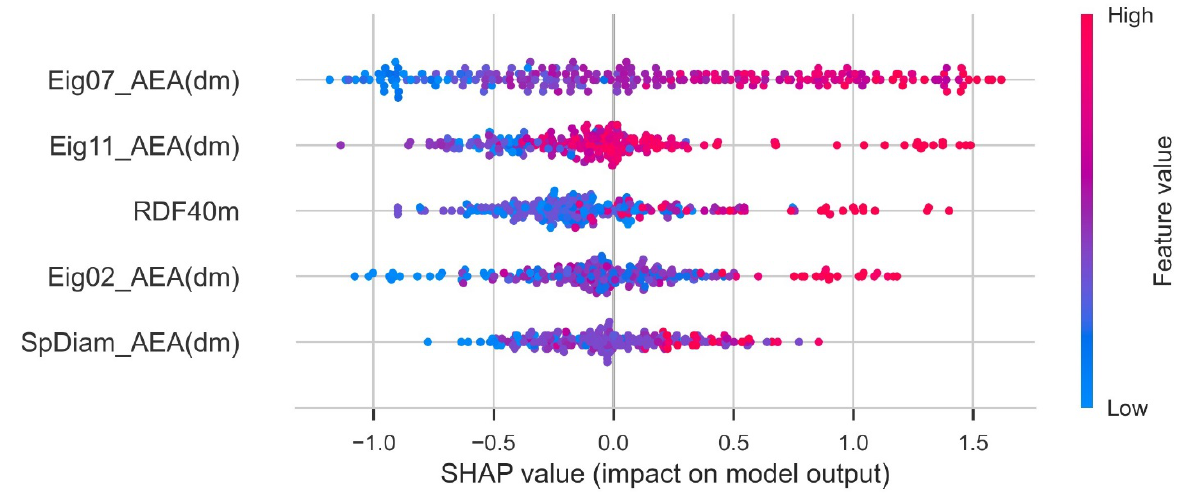
Figure 6. SHAP plot for parameters.